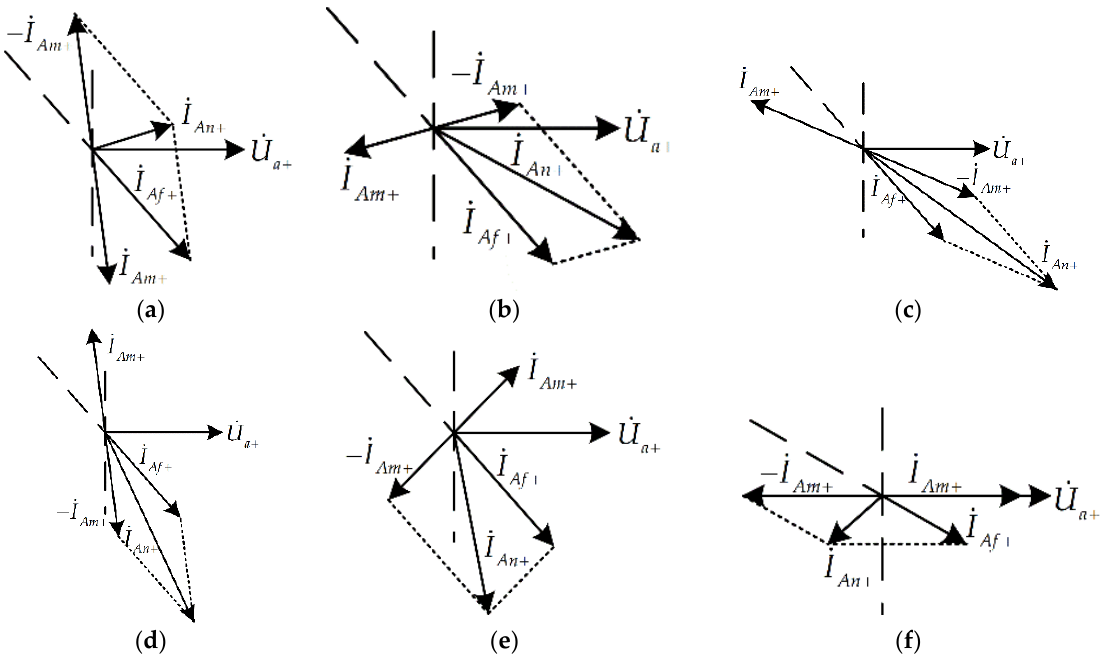
Figure 15. Possible phase relationships among positive-sequence component İ Am + of current provided by the interconnector, positive-sequence component İ An + of current provided by traditional voltage sources, and positive-sequence component İ Af + of the fault path current: ( a )-( c ) İ Am + lags İ Af + and İ Af + lags İ An + ; ( d )-( f ) İ Am + leads İ Af + and İ Af + leads İ An + .